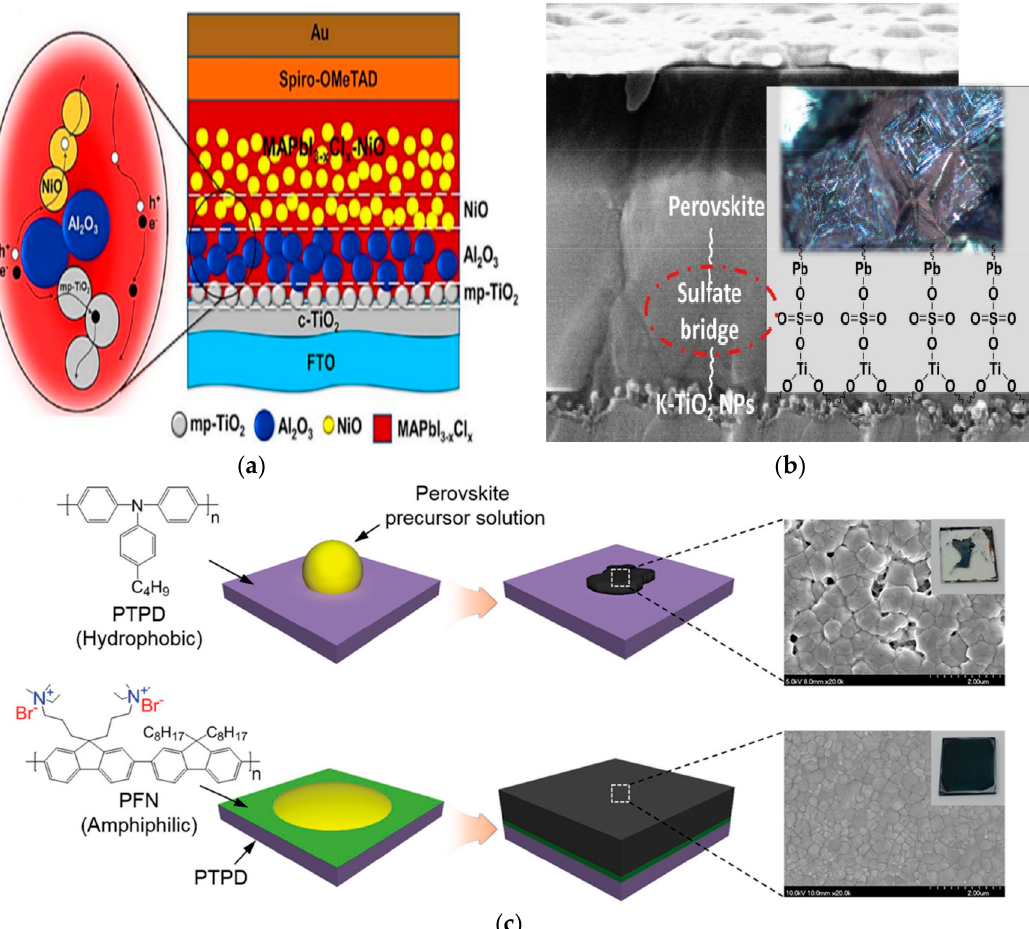
Figure 6. ( a ) Schematic of device configuration of PSC with Al 2 O 3 /NiO interlayer and carrier working paths [55]; ( b ) Schematic illustration of alkali-TFSI salt-doped mesoporous layer, and the surface states bonding with electron transport layer (ETL) and perovskite [60]; ( c ) Schematic illustrations of perovskite film formation on organic hole transport layer (HTLs) with and without the interfacial compatibilizer PFN, and corresponding photographs and SEM images [62]. Table 3. Summary of research about improving the PCE of PSC by interfacial engineering. Interlayer Ref.